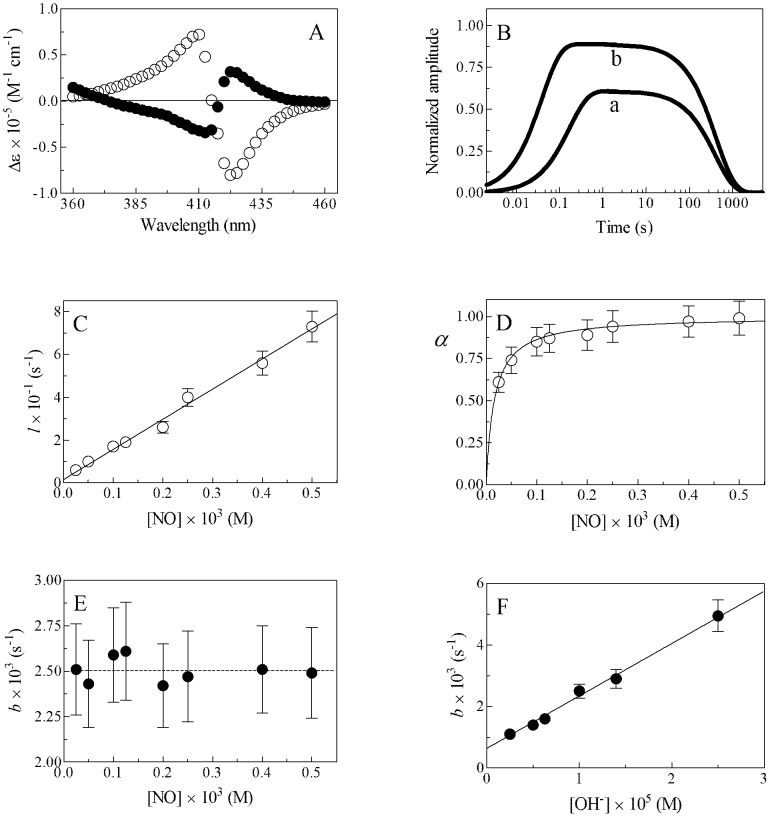
Reductive nitrosylation of Mt-trHbN(III), at 20.0°C.(A) Difference absorbance spectra of Mt-trHbN(III) minus Mt-trHbN(III)-NO and of Mt-trHbN(III)-NO minus Mt-trHbN(II)-NO (open and fillrd circles, respectively), at pH 9.0. (B) Normalized averaged time courses of Mt-trHbN(III) reductive nitrosylation, at pH 9.0. The NO concentration was 2.5×10−5 M (trace a) and 2.0×10−4 M (trace b). The time course analysis according to Eqns (5a)–(5c) allowed the determination of the following values of parameters α, l, and b: trace a - α = 0.61, l = 6.0 s−1, and b = 2.5×10−3 s−1; and trace b - α = 0.89, l = 2.6×101 s−1, and b = 2.4×10−3 s−1. (C) Dependence of l on [NO] for Mt-trHbN(III) reductive nitrosylation, at pH 9.0. The continuous line was generated from Eqn. (6) with l
on = (1.4±0.2)×105 M−1 s−1 and l
off = 1.6±0.2 s−1. (D) Dependence of α on [NO] for Mt-trHbN(III) reductive nitrosylation, at pH 9.0. The continuous line was generated from Eqn. (7) with L = (1.6±0.2)×10−5 M. (E) Dependence of b on [NO] for Mt-trHbN(III) reductive nitrosylation, at pH 9.0. The average b value is 2.5×10−3 s−1 (dashed line). (F) Dependence of b on [OH−] for Mt-trHbN(III) reductive nitrosylation. The continuous line was generated from Eqn. (8) with b
OH− = (1.7±0.2)×102 M−1 s−1 and b
H2O = (6.4±0.7)×10−4 s−1. The Mt-trHbN(III) concentration was 1.5×10−6 M. Where not shown, standard deviation is smaller than the symbol. For details, see text.